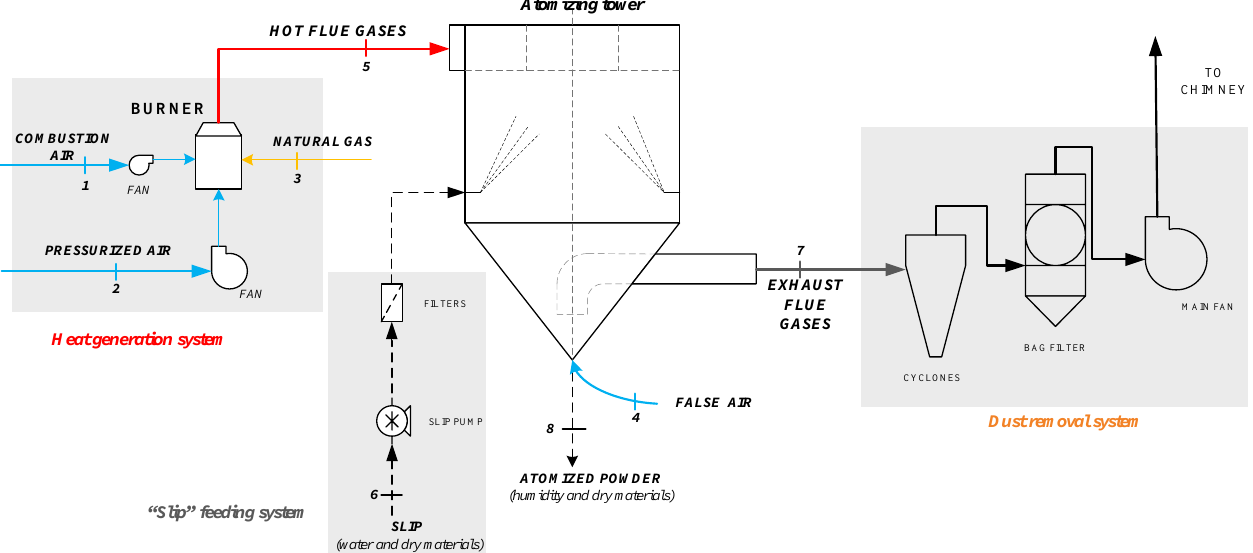
Figure 3. Schematic of the spry dryer unit.